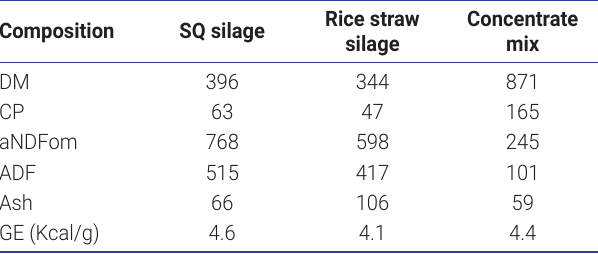
Table 2. Ingredients of the concentrate mix used in in vivo experi- ments (exp 3 and 4, % as fed)